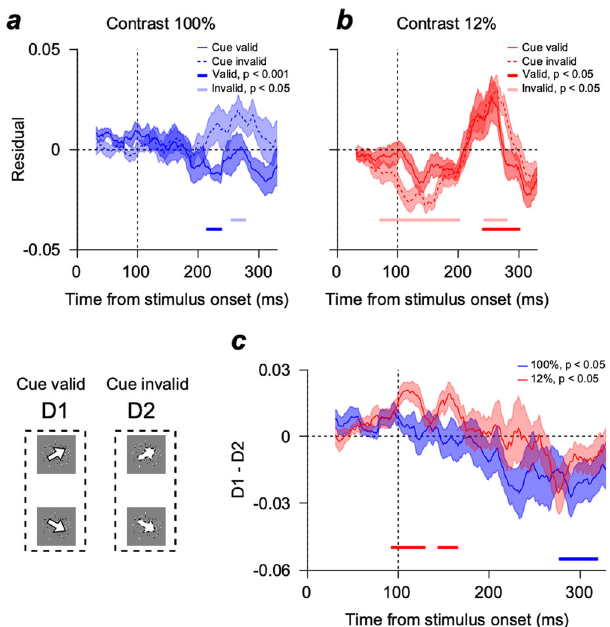
Fig. 7 Residuals from the model prediction. a EEG activity pattern dissimilarity (Mahalanobis distance) of the residuals in the time window of 30 and 330 ms from the stimulus onset when the stimulus contrast was 100%. The solid blue and dashed lines are the EEG dissimilarity when the cue was valid and invalid. b Pattern dissimilarity of the residuals when the stimulus contrast was 12%. The fi gure format is the same as Fig. 7a. The dark-colored line (valid) and light-colored line (invalid) at the bottom of each plot show the time points where Mahalanobis distance was signi fi cantly different from zero (two-sided cluster-based permutation test, n = 14, cluster-de fi ning threshold p < 0 : 05, corrected signi fi cance level p < 0 : 05, 50,000 permutations). c Difference between the residual dissimilarity patterns of valid and invalid conditions. Neural direction discrimination in the cue-valid was signi fi cantly better than in the cue- invalid condition when stimulus contrast was 12% (92 – 130 ms, two-sided cluster-based permutation test, n = 14, cluster-de fi ning threshold p < 0 : 05, corrected signi fi cance level p < 0 : 05, 50,000 permutations). The color- shaded areas denote standard